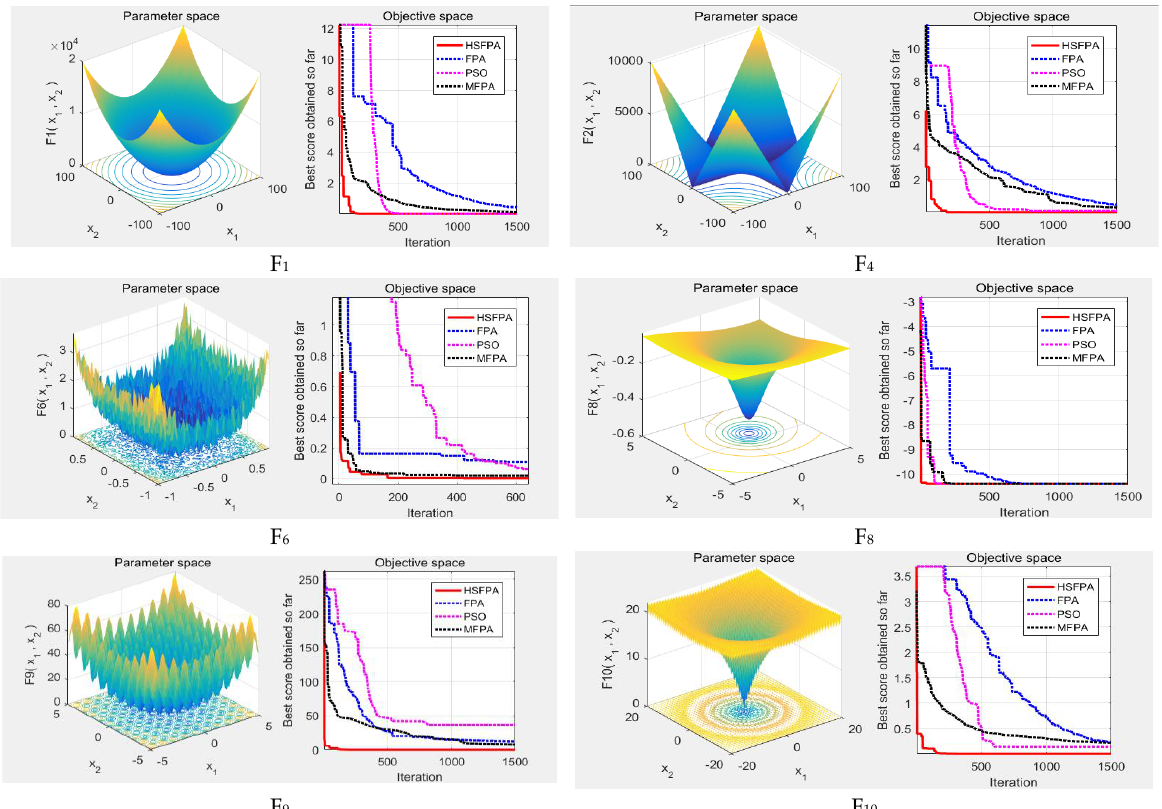
Figure 3. The evaluated experimental results of the proposed HSFPA with the FPA, MFPA, and PSO algorithms for testing functions in viewing obtained curves for the selected functions.